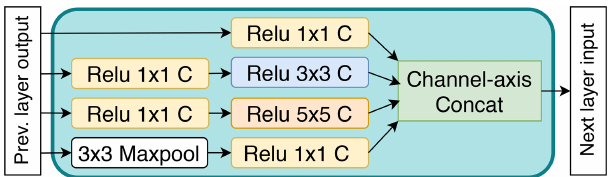
Figure 4. Details of the inception module used in Fig.